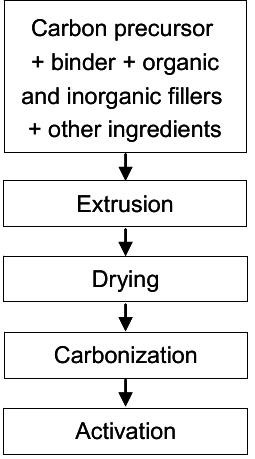
Figure 6. Preparation steps for integral carbon